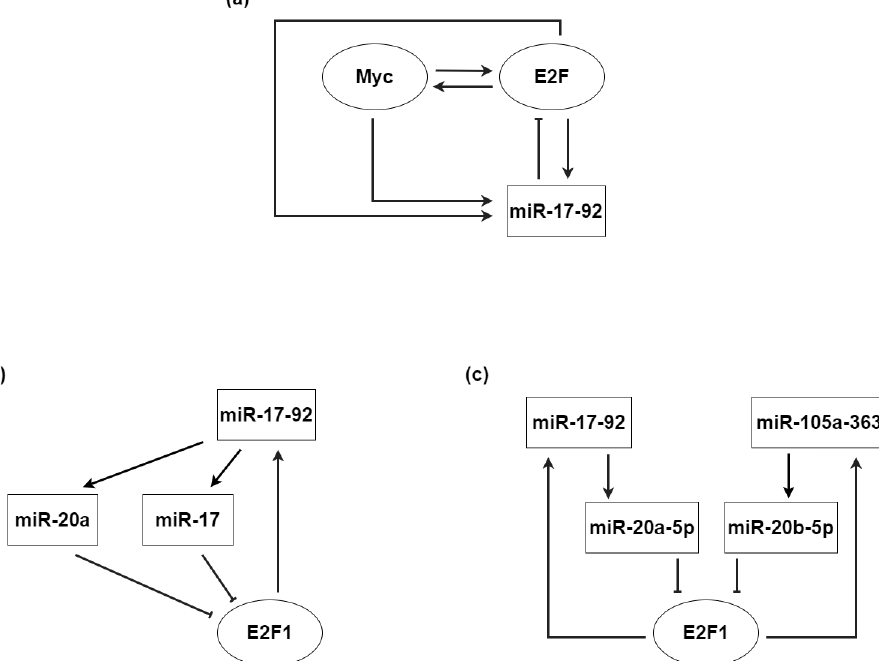
Figure 5. Representation of Myc-controlled networks involving miRNAs. Edges with a pointed head represent positive (activatory) regulation, whereas edges with a flat head represent negative (repressive) regulation. ( a ) Representation of regulatory interactions between Myc, the E2F family, and the miR-17-92 cluster. The miR-17-92 cluster can lead to the generation of large amplitude E2F1 oscillations thanks to the timescale gap between transcriptional and miRNA-mediated regulation. ( b ) Negative feedback loops between miR-17 and E2F1 and between miR-20a and E2F1 in mouse palatal mesenchymal cells. MiRNA-mediated repression avoids uncontrolled cell proliferation. ( c ) Negative feedback loops between miR-20a-5p and E2F1 and between miR-20b-5p and E2F1 in myoblasts. The two miRNAs promote cell